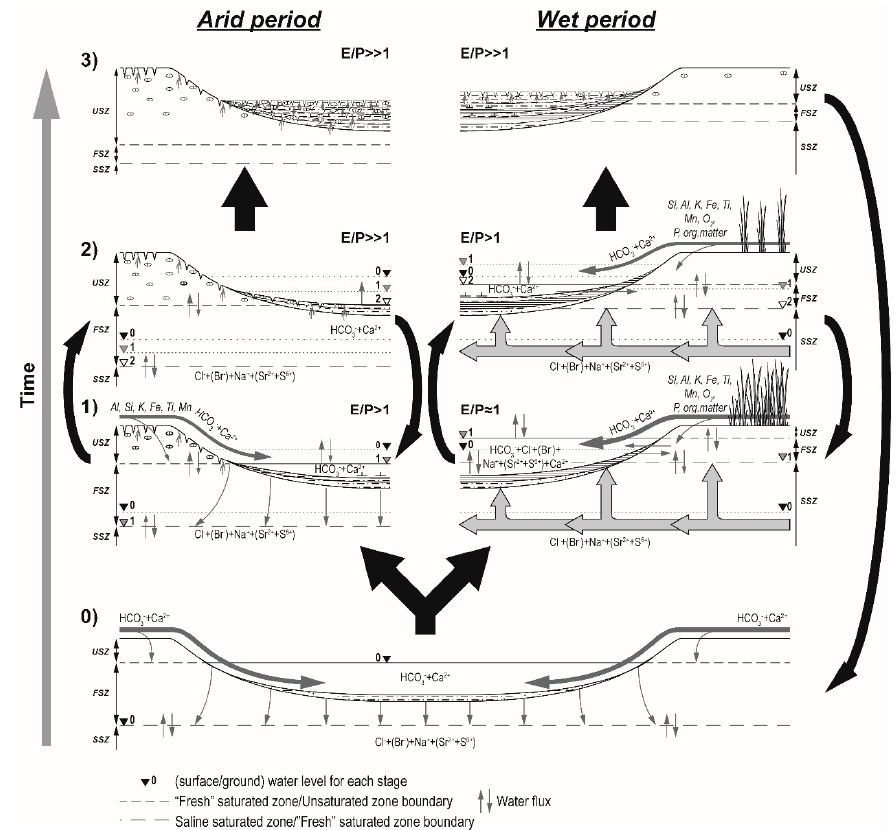
Figure 8. Conceptual model relating sedimentary facies, water chemistry and levels, as well as hydroclimate for the Lagunas Reales. USZ: unsaturated zone, FSZ: “fresh” water saturated zone, SSZ: “saline” water saturated zone. E / P: Evaporation / precipitation ratio. Sedimentary facies key as in Figure 3.